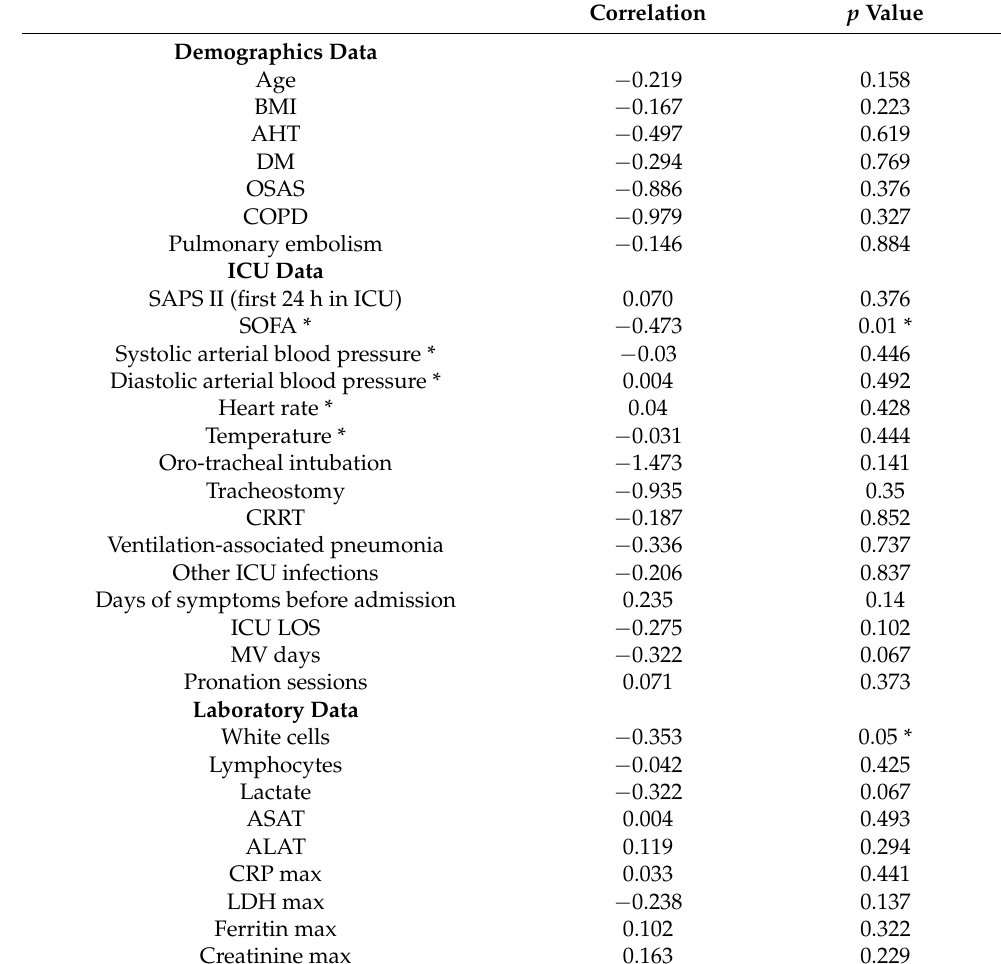
Table 3. Correlation analysis with acute activities of daily life (ADLs) evaluated by Barthel